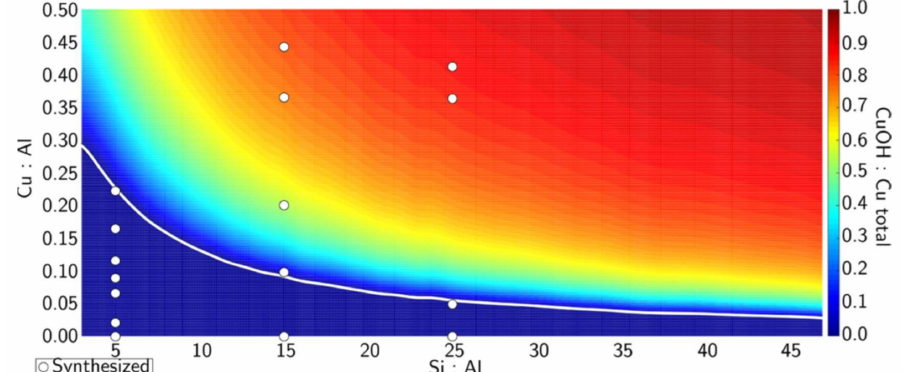
Figure 2. The predicted Cu site compositional phase diagram versus Si:Al and Cu:Al ratios, with the color scale indicating predicted fractions of CuOH. The white line demarcates the transition from a [Z2-CuII]-only region to a mixed [Z2-CuII]/[Z-CuII-OH] region. White circles indicate compositions of synthesized Cu-SSZ-13 samples used to verify the computed predictions. Reprinted with permission from J. Am. Chem. Soc. , 2016 , 138 , 6028–6048. Copyright 2016, American Chemical Society. Even though [Cu(H 2 O) 6 ] 2+ and [Cu(OH)(H 2 O) 5 ] + ions are likely